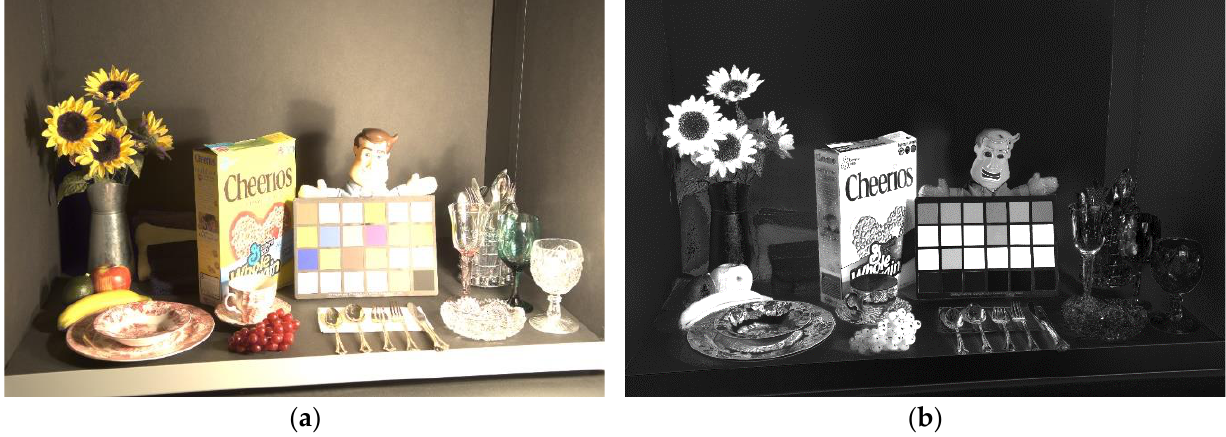
Figure 4. Input image and color enhancement map; ( a ) input image with Gamma tone mapping for visualization; ( b ) enhancement stop mask.